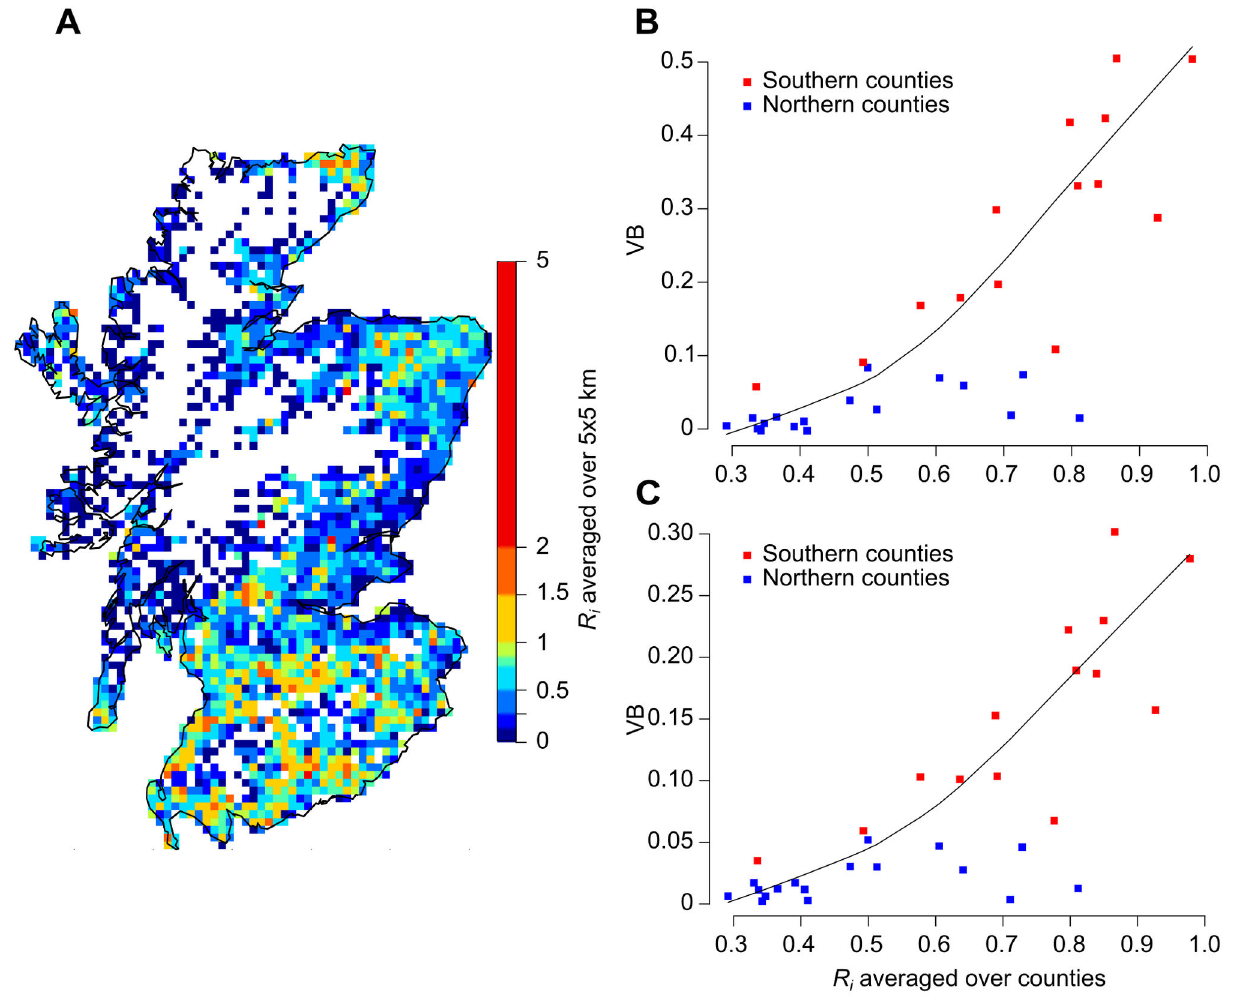
Figure 4. Influence of R on the benefit of the vaccination policy. Spatial distribution of the farm-level basic reproductive ratio, i R (A) and its relation with the FMD vaccination benefit (VB) in Scotland. Vaccination benefit was measured based on the number of i infected premises (B) and the epidemic duration (C) in the situation where 1 premise was infected at first detection (early detection). Values of R show in B and C are the average across all farms in each county. Note also that county-level estimates in B and C were i grouped into the two areas as defined in this study (Figure 2). The colour scale used in the map shows the average value in a 5 × 5 km grid lattice. Estimates of R were computed based on the Scottish Agricultural Census June 2011 and using the method i described in [15]. Solid curve in B and C represents the smooth fit to better visualize trends in the data set. The fit was generated using the locally weighted scatter plot smoother (LOWESS)